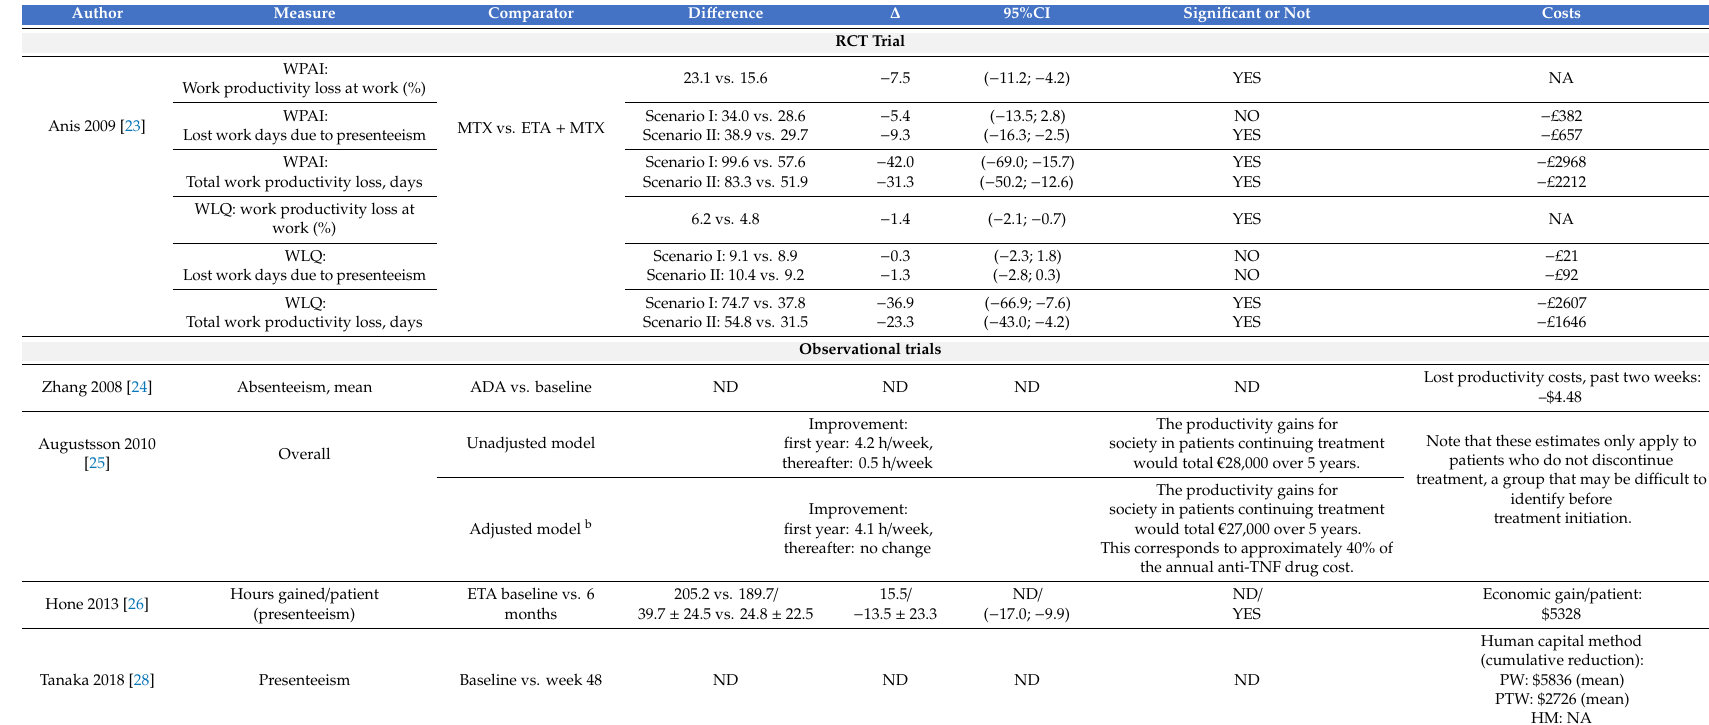
Table 3. E ff ect of biological treatment on presenteeism